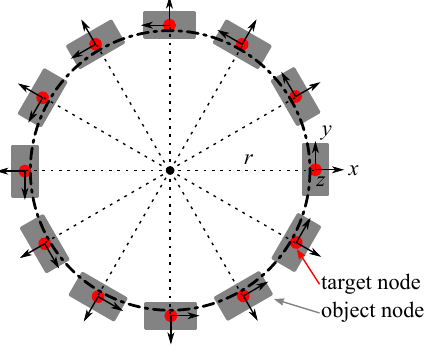
Figure 5: Implementation of contact element for human-exoskeleton interaction forces